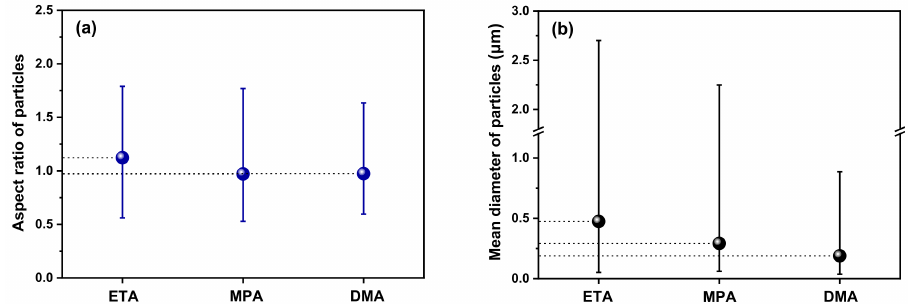
Figure 6. Particle characteristics of magnetite particles using an image analyzer: ( a ) aspect ratio and ( b ) mean